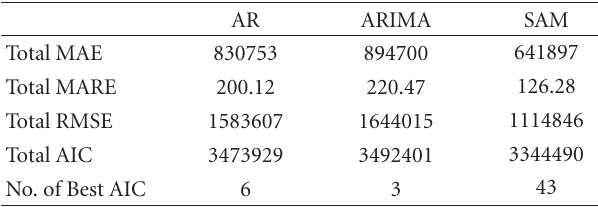
Table 6: Comparison between AR, ARIMA, and SAM using